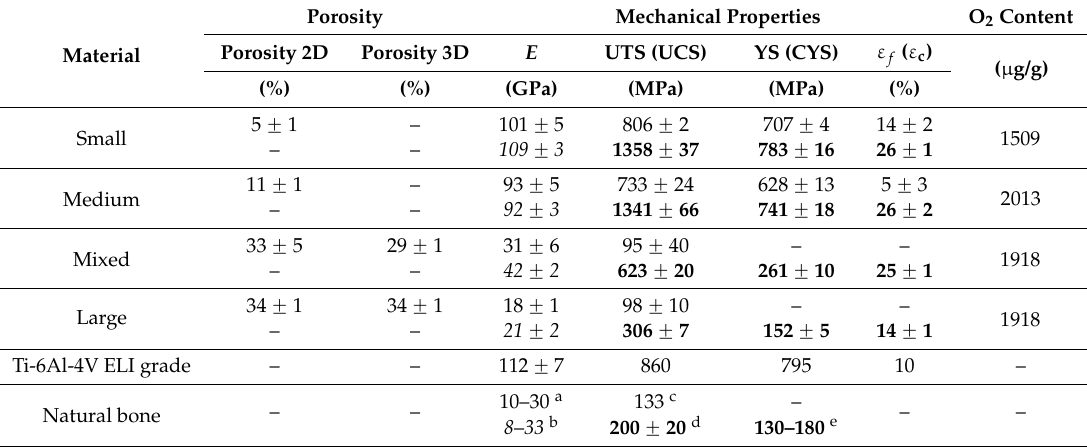
ε f : elongation to fracture, ε c : compressibility, UCS: ultimate compression strength, UTS: ultimate tensile strength and YS: yield strength.